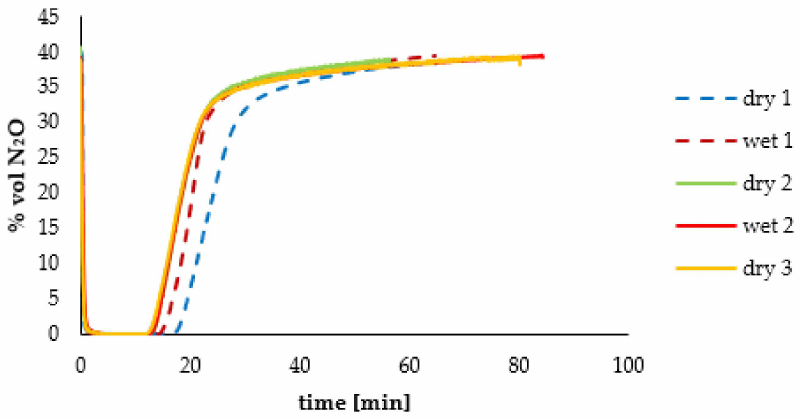
Figure 6. Wet and dry tests after the first dry test (dry 1).